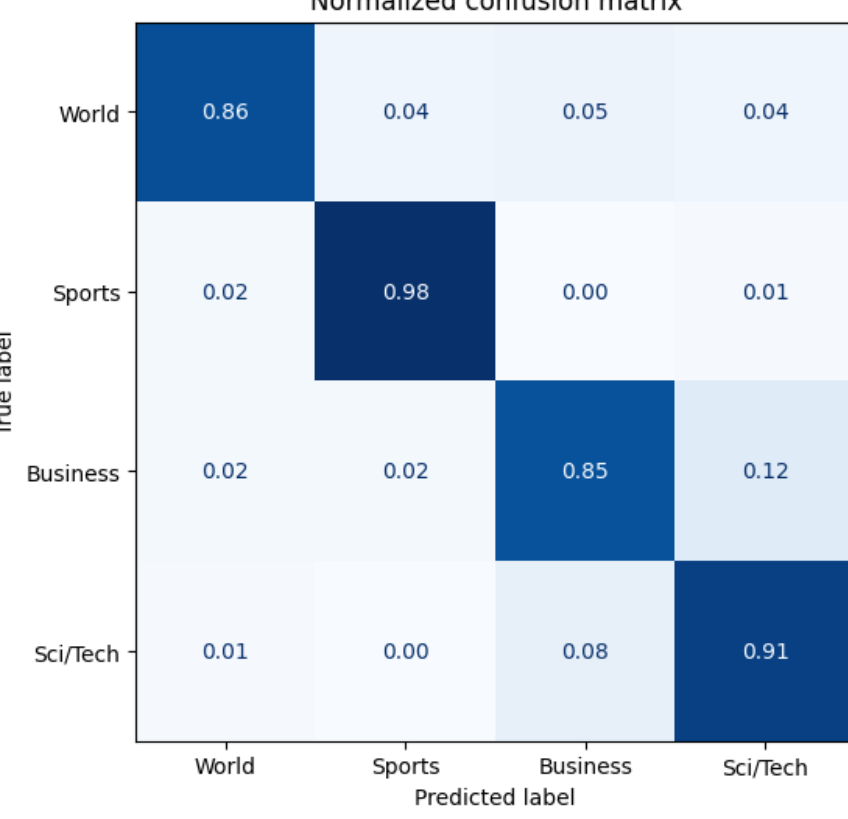
Figure 14. Antipode3 Run1 Confusion Matrix on AG-News. When comparing the original model with the three Antipode3 models (Run1), the best model is the most effective, and the direction of improvement is consistent across all of them: they all demonstrate an increased accuracy in recognizing the World class, and